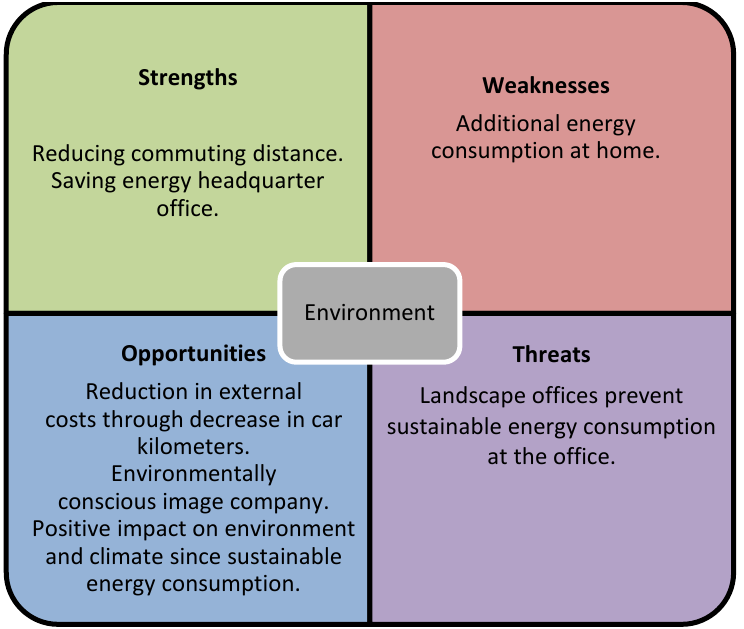
Figure 5. SWOT analysis of the impact of teleworking on the environment (MOBI,